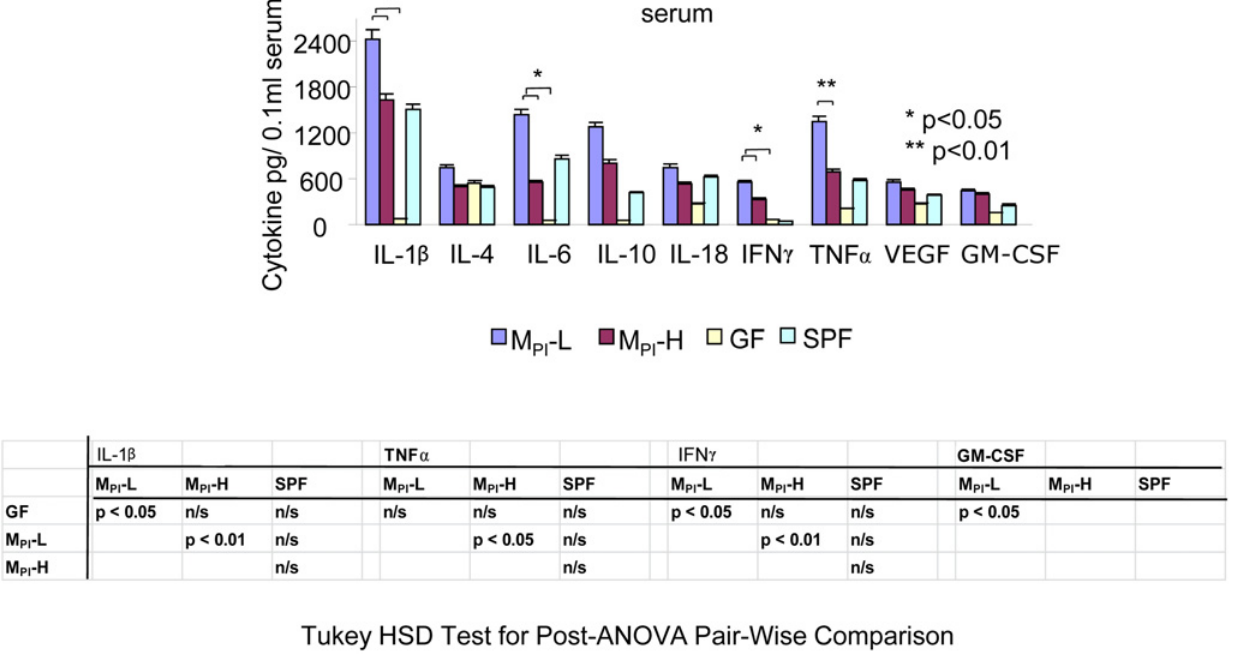
Fig 5. M PI effects on systemic immune and inflammatory cytokine expressions by multiplex immunoassay. Multiplex immunoassay of immune and inflammatory cytokine expressions in serum collected from preweaned GF and M PI -L, H and SPF. The levels of these cytokines are presented as mean ± SEM. One-way ANOVA with post-hoc Tukey ’ s honest significance (HSD) test was used to compare the groups.